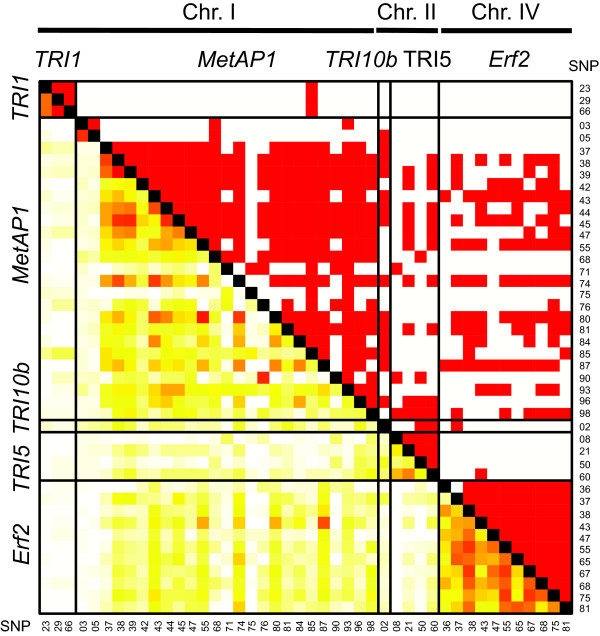
Pairwaise linkage disequilibrium (LD). The structure of LD within and among five candidate genes for 77 Fusarium isolates. Significant LD (P < 0.05, above diagonal) and LD measured as r2 between all pairs of selected SNP loci (below diagonal). The horizontal and vertical lines separate the candidate genes, red coloring indicates significant LD and the higher the r2 values (r2 ≥ 0.1), the darker is the used color, white indicates non-significant LD or r2 = 0.